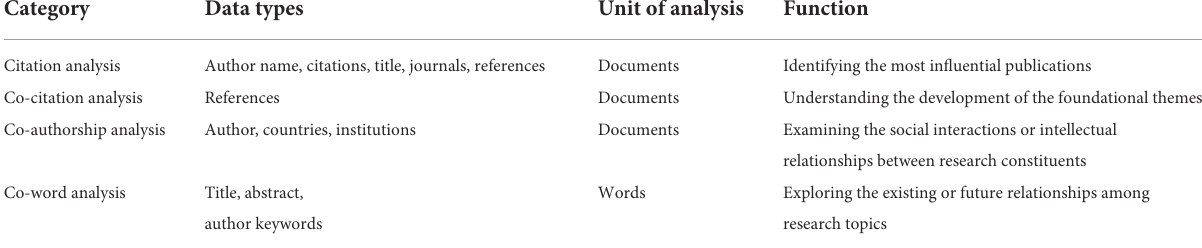
TABLE 1 Techniques for science